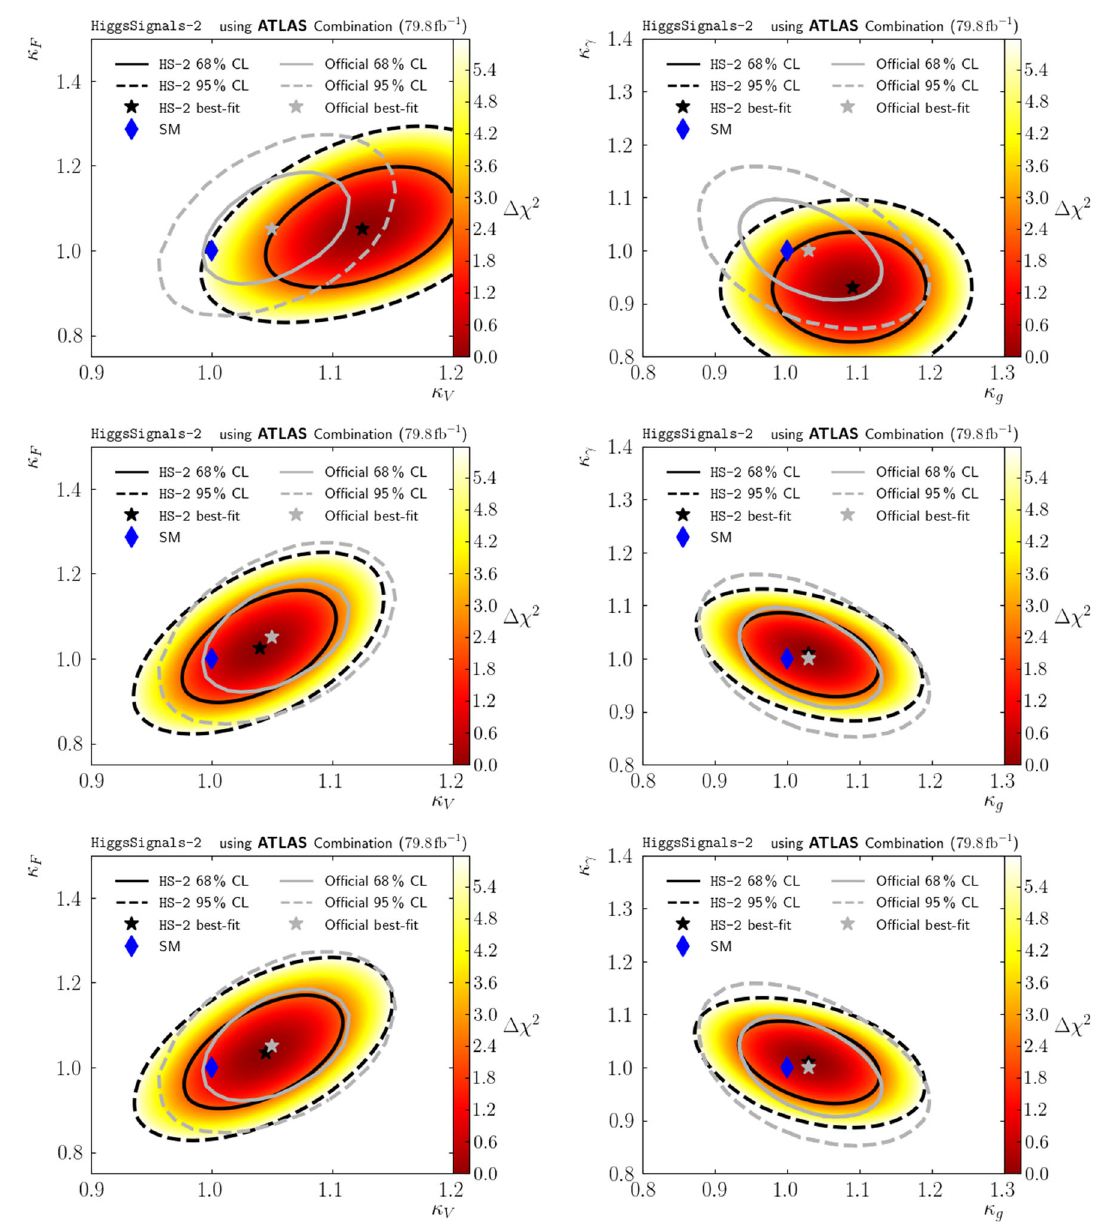
Fig. 13 Performance test in the ( κ F ,κ V ) plane ( left panels ) and the ( κ g ,κ γ ) plane ( right panels ) using the STXS measurements of the ATLAS Run-2 Higgs combination with 80 fb − 1 as HiggsSignals input. The contours and best fit points are indicated as in Figs. 10, 11